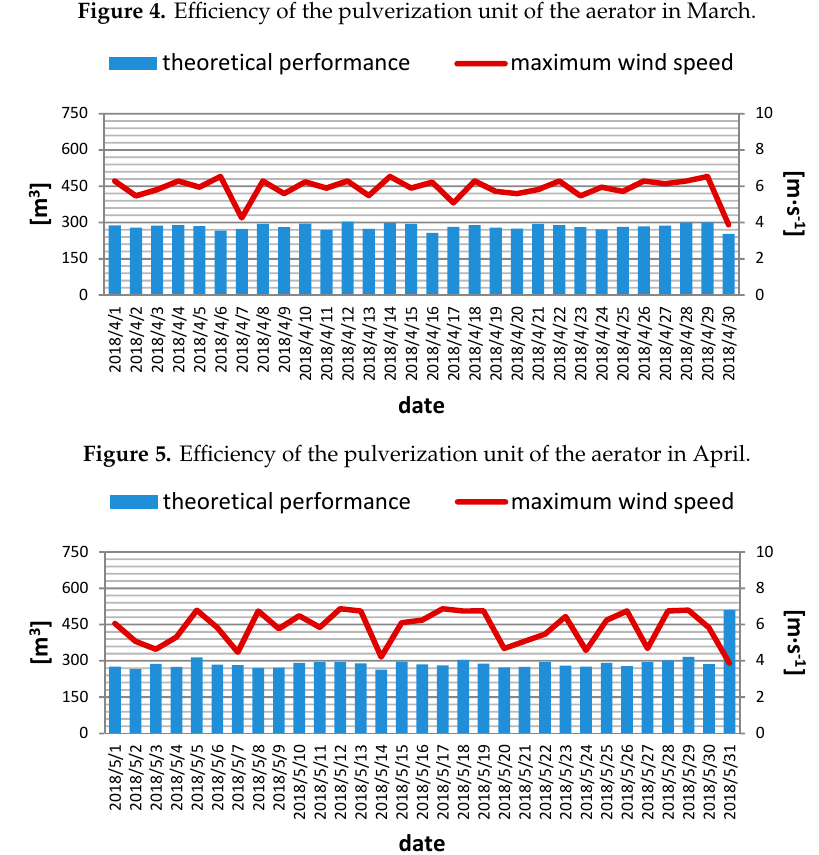
Figure 6. E ffi ciency of the pulverization unit of the aerator in Figure 6. Efficiency of the pulverization unit of the aerator in May.